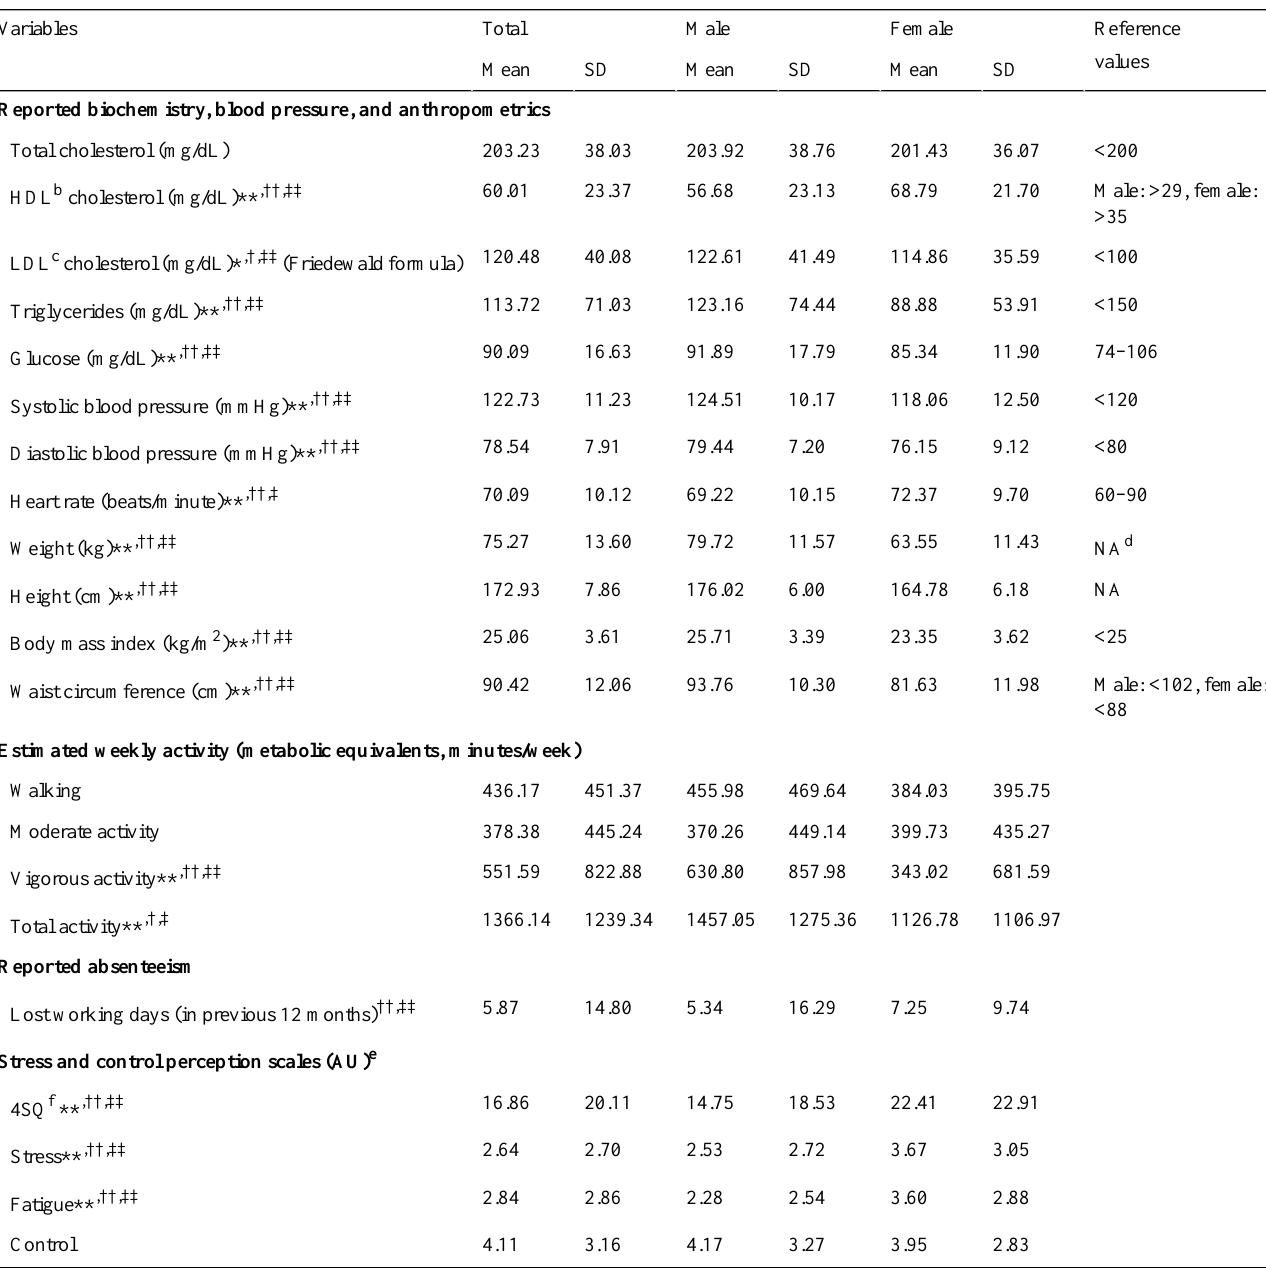
Table 2. Descriptive data (N = 683 participants)